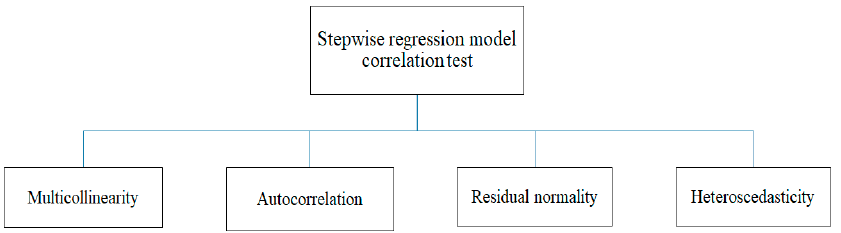
Figure 18. Correlation test of regression model.